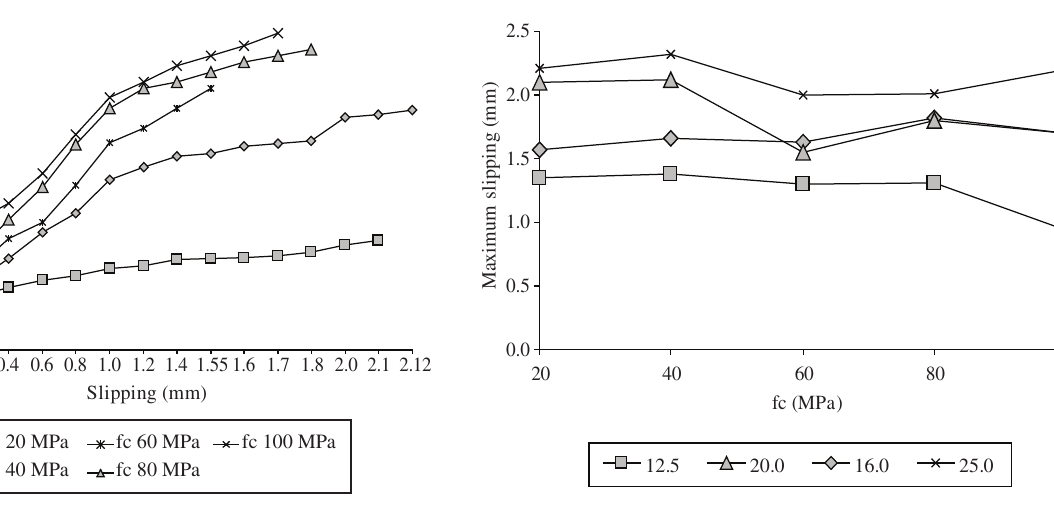
Figure 6. Maximum slipping vs. strength of concrete. Figure 4. Bond Stress vs. Slipping ( f = 20.0 mm).